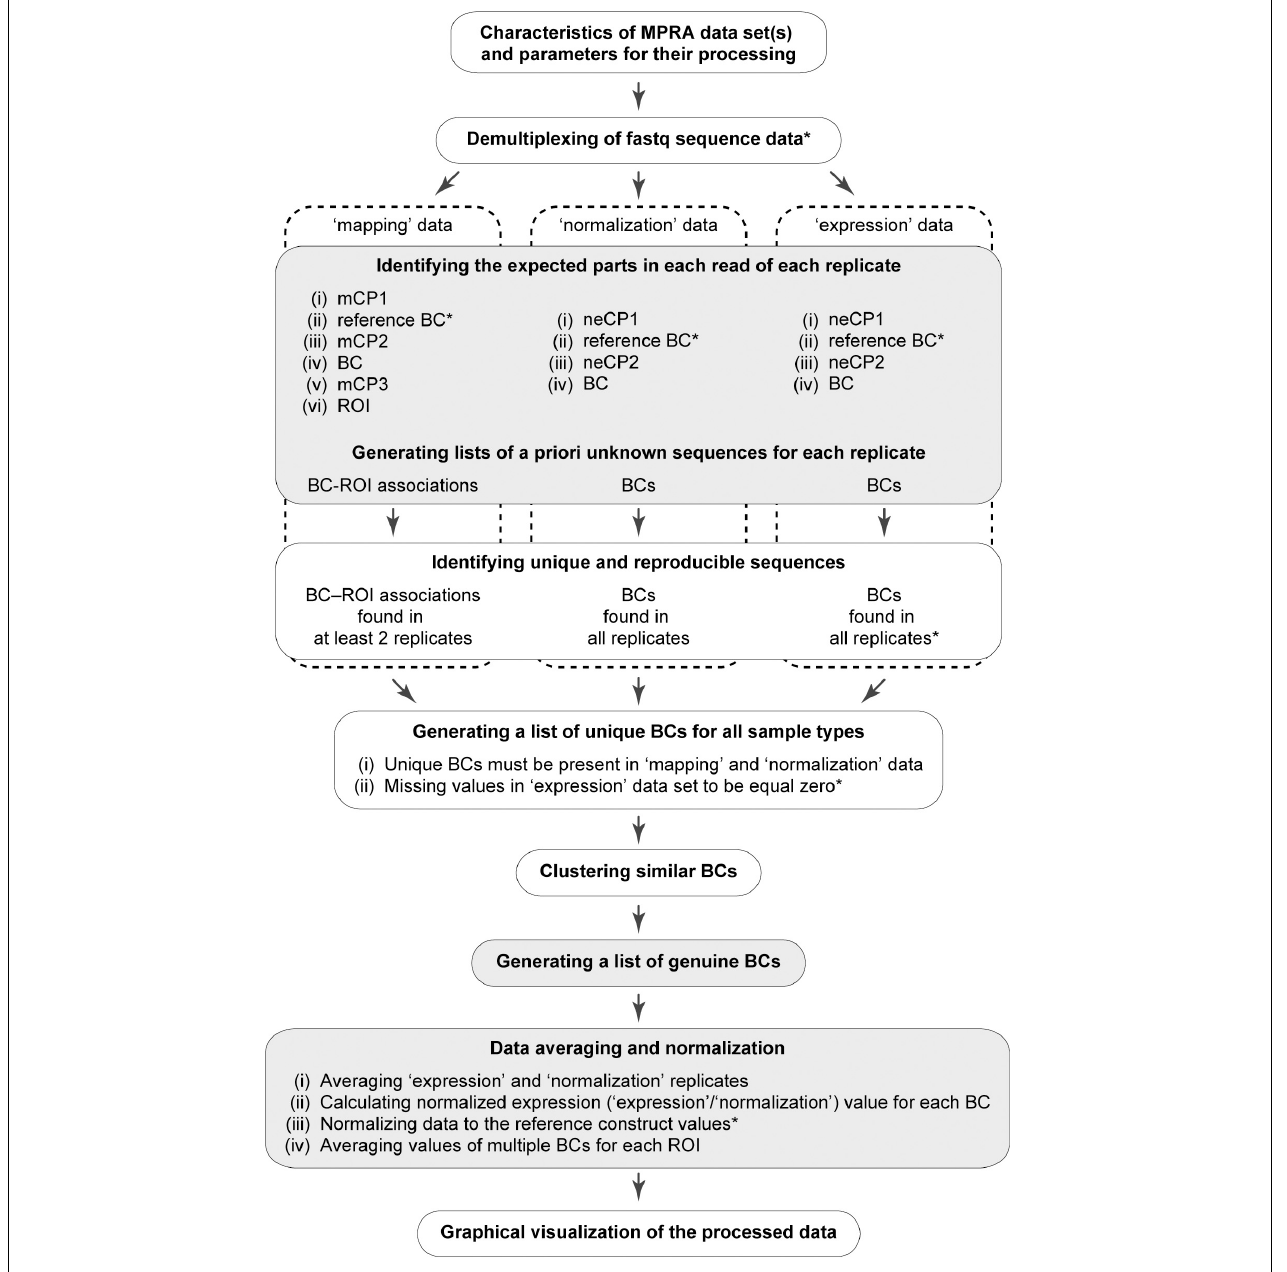
FIGURE 2 | Schematic overview of the MPRAdecoder pipeline. The optional steps are marked by an asterisk. The steps at which the pipeline saves intermediate or final results are marked by